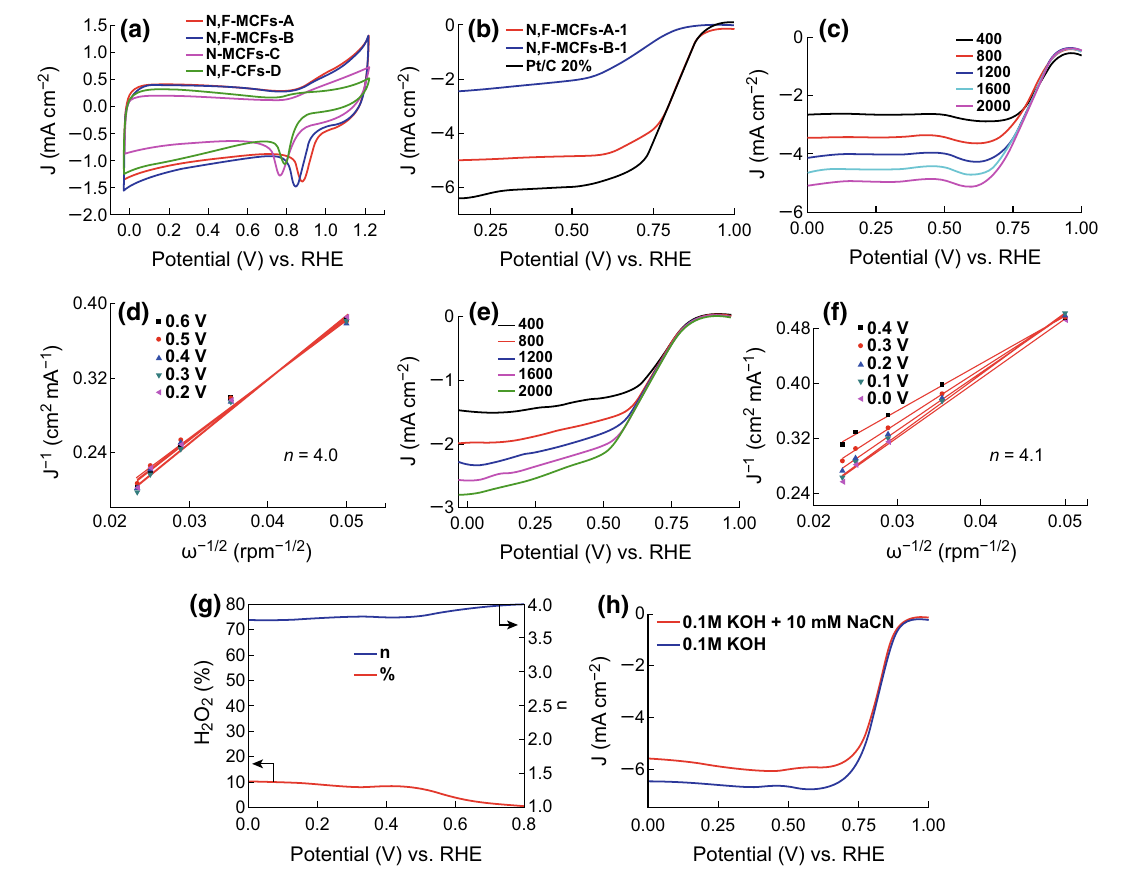
Fig. 4 a CV curves of N, F-MCFs-A; N, F-MCFs-B; N-MCFs-C; and N, F-CFs-D in O 2 -saturated 0.1 M KOH with a scan rate of 10 mV s −1 . b LSV curves of N, F-MCFs-A; N, F-MCFs-B; and commercial 20% Pt/C in O 2 -saturated 0.1 M KOH with a scan rate of 10 mV s −1 . LSV curves and K–L plots of c , d N, F-MCFs-A and e, f N, F-MCFs-B. g Percentage of H 2 O 2 yield and electron transfer number ( n ) of N, F-MCFs-A. h LSV curves of N, F-MCFs-A with and without 10 mM NaCN in O 2 -saturated 0.1 M KOH with a scan rate of 10 mV s